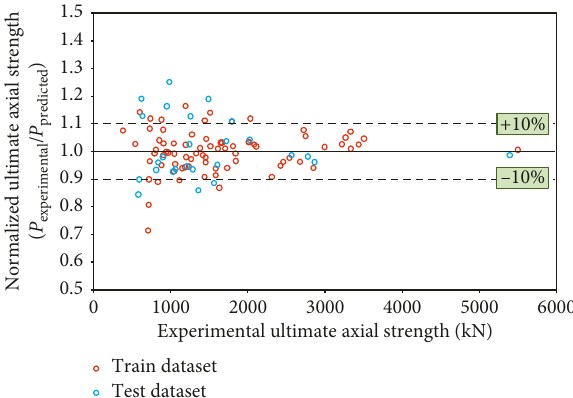
Figure 5: Prediction capability of the proposed model on the ultimate axial strength of CFDST